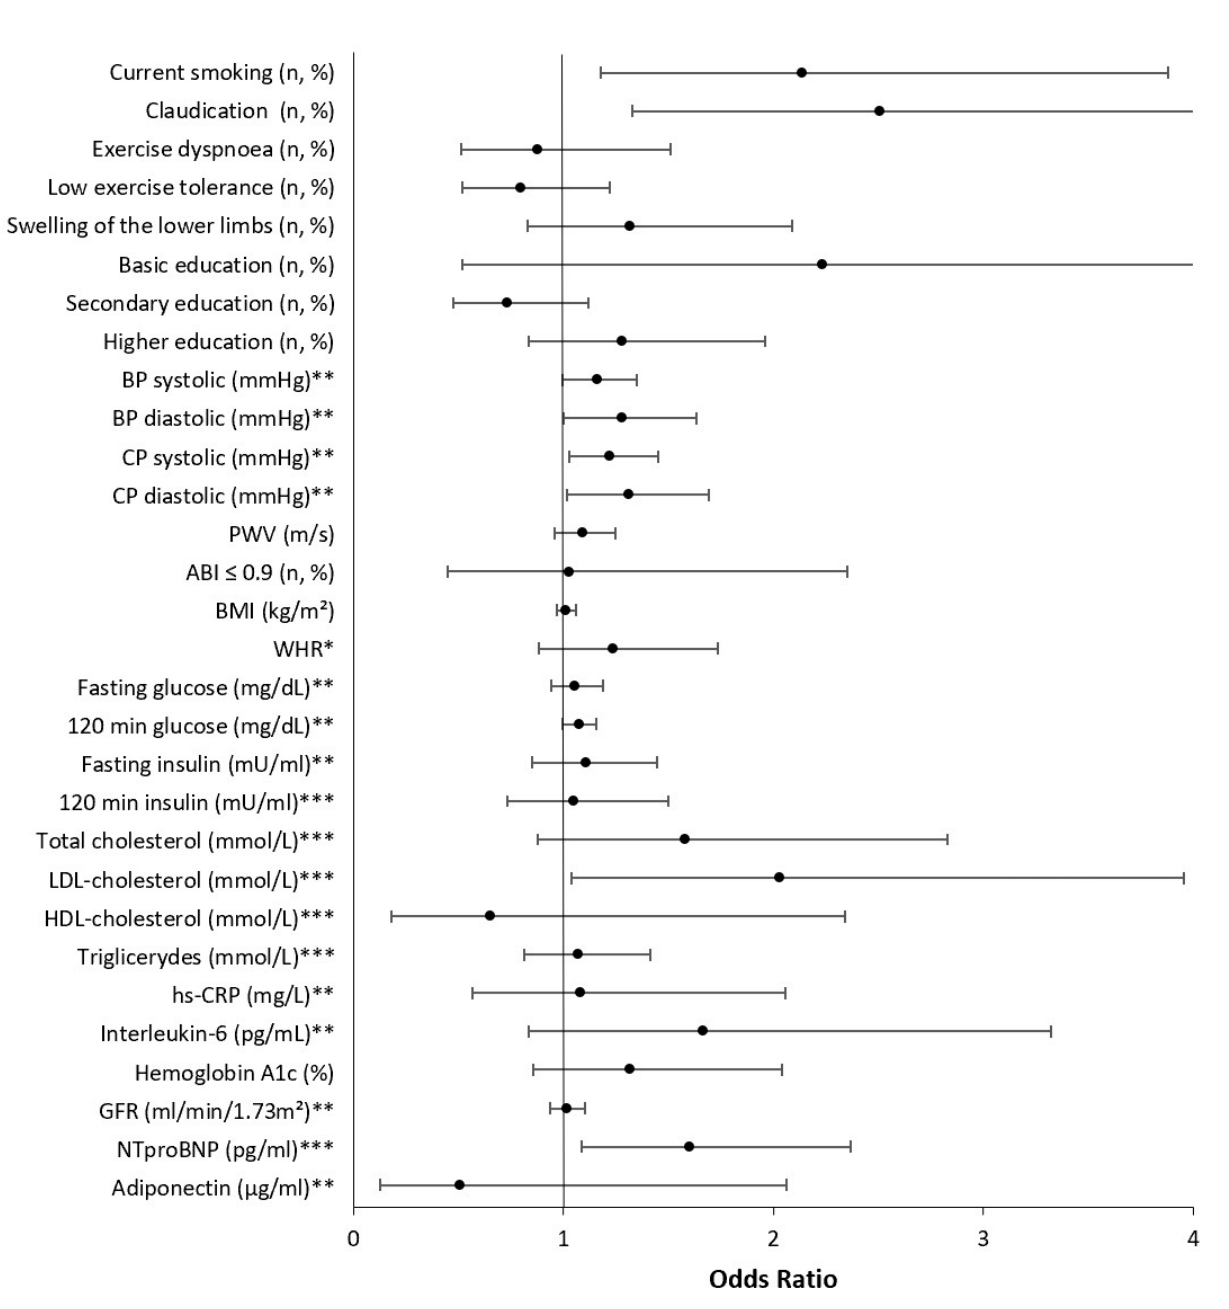
Figure 2. Predictors of APCA in a model adjusted for age, gender, hypercholesterolemia, diabetes, hypertension, history of myocardial infarction, and stroke. * Per 0.1 units; ** per 10 units; *** per 100 units. BP, blood pressure; CP, central pressure; PWV, pulse wave velocity; ABI, ankle-brachial index; IMT, intima-media thickness; BMI, body mass index; WHR, waist-to-hip ratio; LDL, low- density lipoprotein; HDL, high-density lipoprotein; hs-CRP, high-sensitivity C-reactive protein; GFR, glomerular filtration rate; NTproBNP, n-terminal pro-brain natriuretic peptide. In the logistic regression analysis with stepwise elimination of variables listed in Table 3, the strongest factors associated with APCA were current smoking ( p = 0.012) and diastolic central pressure ( p =